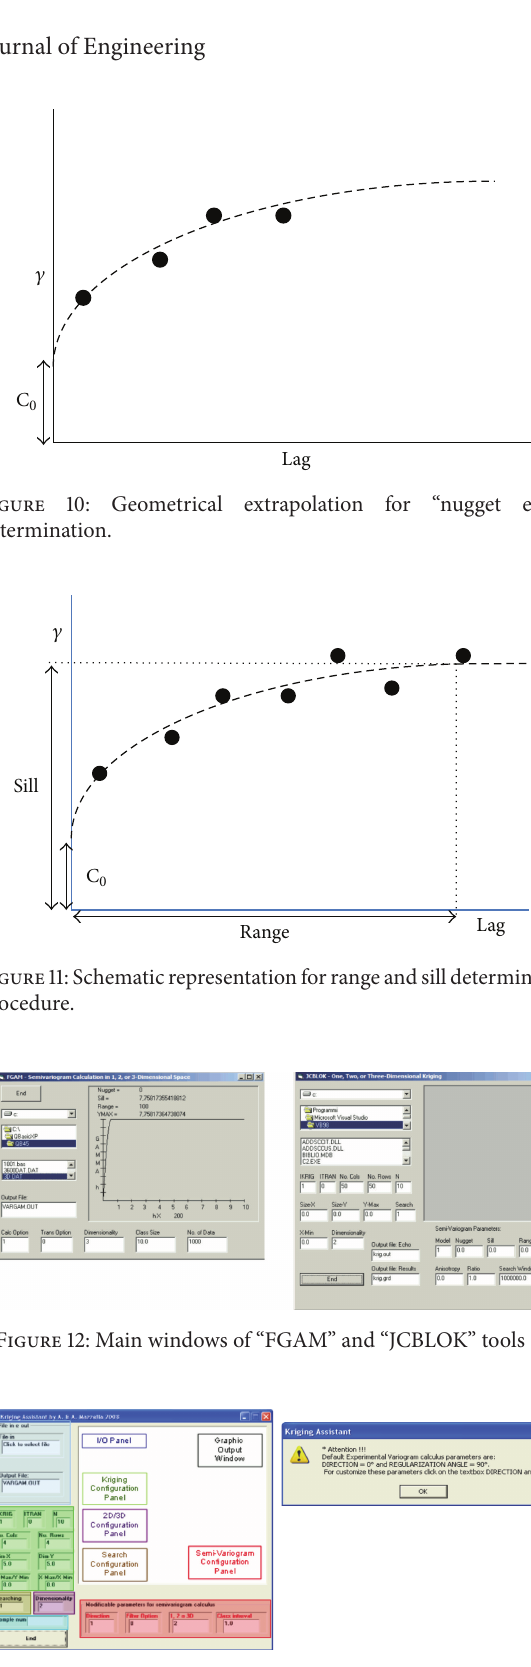
Figure13:Ontheleft,thecontrolpanelsformingKAmainwindows are shown. On the right, the alert message that informs the user about the default parameters used for experimental semivariogram calculus is shown.